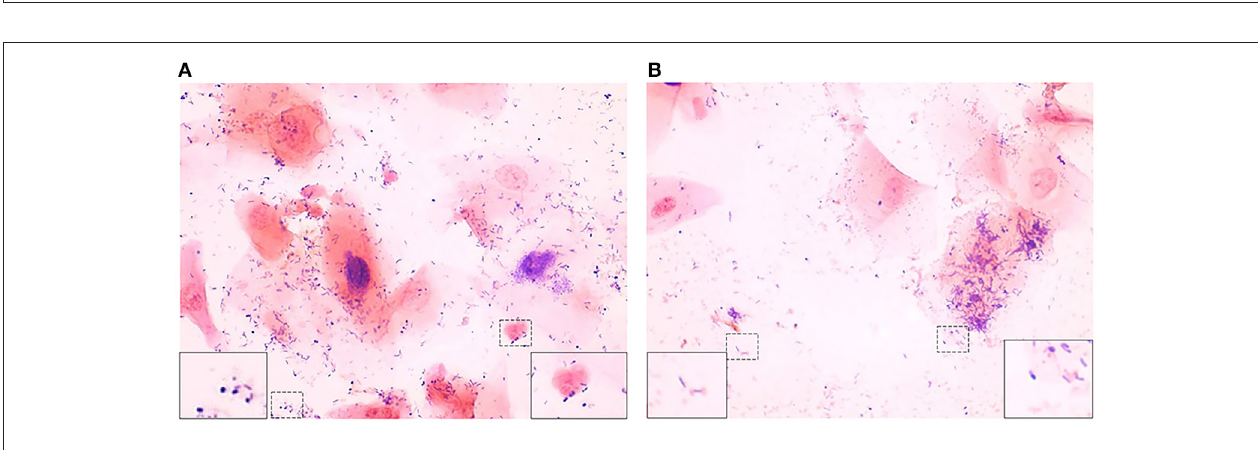
FIGURE 2 | Gram-positive bacteria seen in Gram-stained slides of sheep vaginal secretions. (A) Gram-positive cocci (left dashed box and magnified in insert on left) and Gram-positive diplococci (right dashed box and magnified in insert on right), (B) Gram-positive rods (left dashed box and magnified in insert on left) and pleiomorphic appearance of Gram-positive bacteria (right dashed box and magnified in insert on right). There was poor predictive ability for Gram-positive cocci, rods, and pleiomorphic bacteria, therefore they were not included in the final reduced scoring system (micrographs are × 100 oil